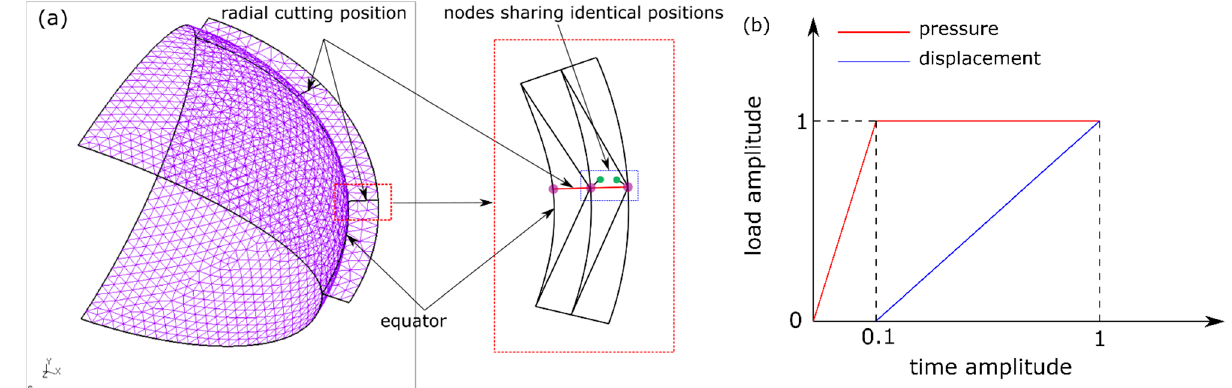
Figure 5. Modelling on accommodating test of ALC: ( a ) FE model; ( b ) loading step.